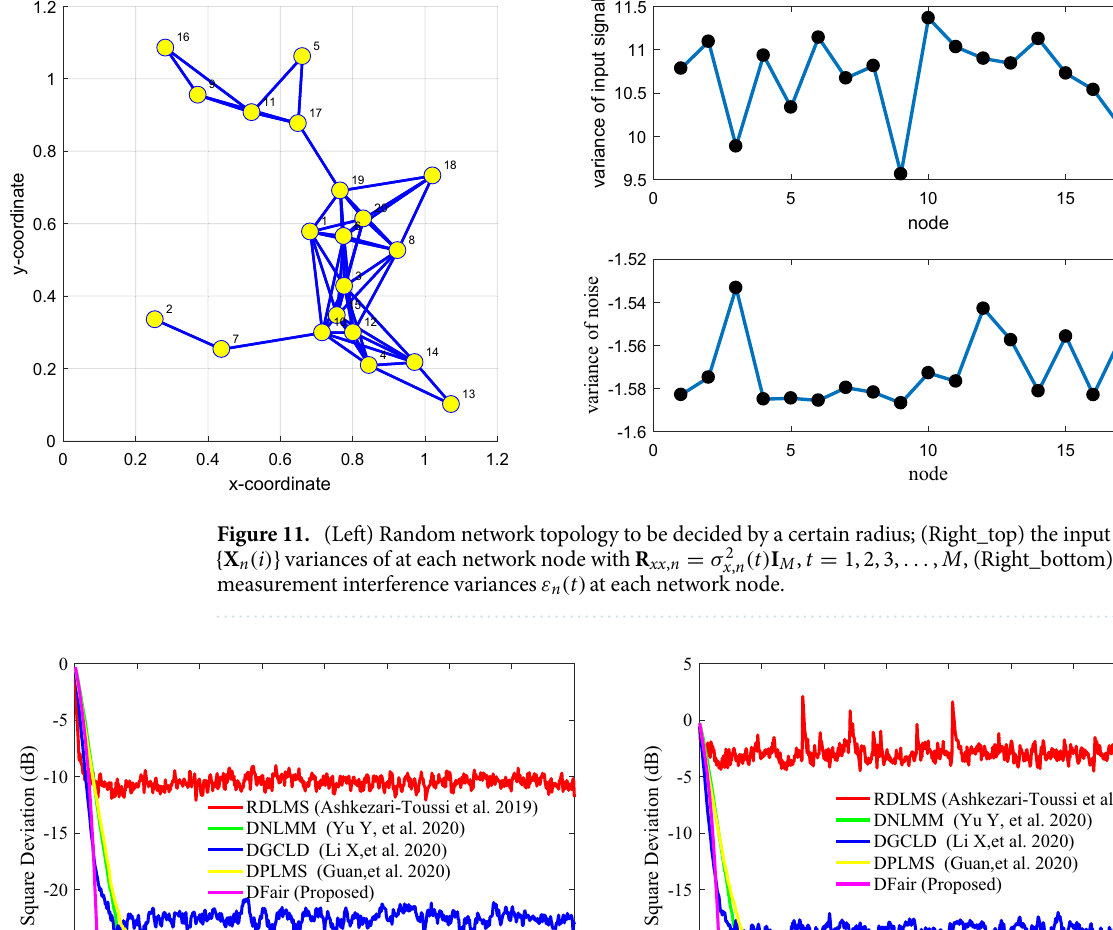
( t ) I M , t = 1, 2, 3, . . . , M , (Right_bottom) the x , n